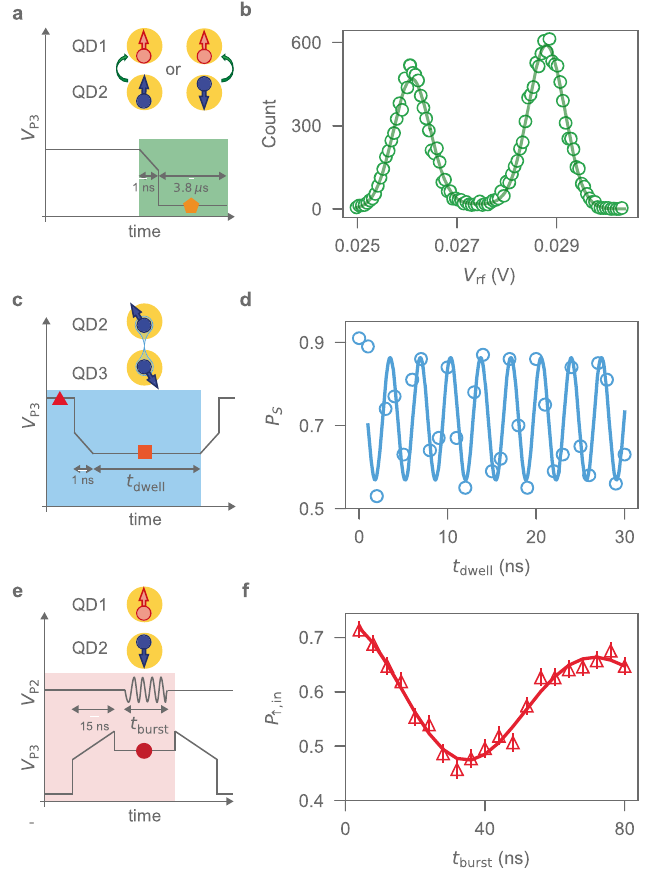
Fig. 2 Ingredients of the QT protocol. a Detuning pulse shape represented for V PR used for the PSB measurement between (1,1,1) and (2,0,1). The detuning is fi rst ramped by rapid adiabatic passage across the (1,1,1) and (2,0,1) resonance, and then instantly pulsed to the measurement point (marked by a pentagon) to avoid spin mixing at the anti-crossing of the singlet and the spin-up polarized triplet. b Histogram of the single-shot PSB measurement signal V rf . The left population indicates (2,1,1) charge state and the right indicates (1,1,1) charge state. c Pulse shape used for preparing a singlet and measuring the ST 0 oscillation in QD2 and QD3, while a random spin is left in QD1. A singlet initialized in QD3 at the triangle marker is separated at the square marker and subsequently measured by the ramp similar to the one used in a . The dwell point (marked by a square) is chosen so that the exchange interaction between Q2 and Q3 is negligible. d ST 0 oscillation in QD2 and QD3. The solid line is a fi t using the Gaussian decaying envelope. e Pulse shape for preparing and measuring the input qubit Q1. To load and measure " 1 +j i , the ramp is slower than those in a . An MW burst is applied at the point marked by a circle. f Rabi oscillation driven by the resonant SWAP using QD1 and QD2. The MW burst time t burst is 4, 8, 12, … , 80 ns. Triangles indicate the values of P " ; in obtained after correcting the readout errors in detecting " +j i . Error bars represent the SE. The solid line is a fi t using 1